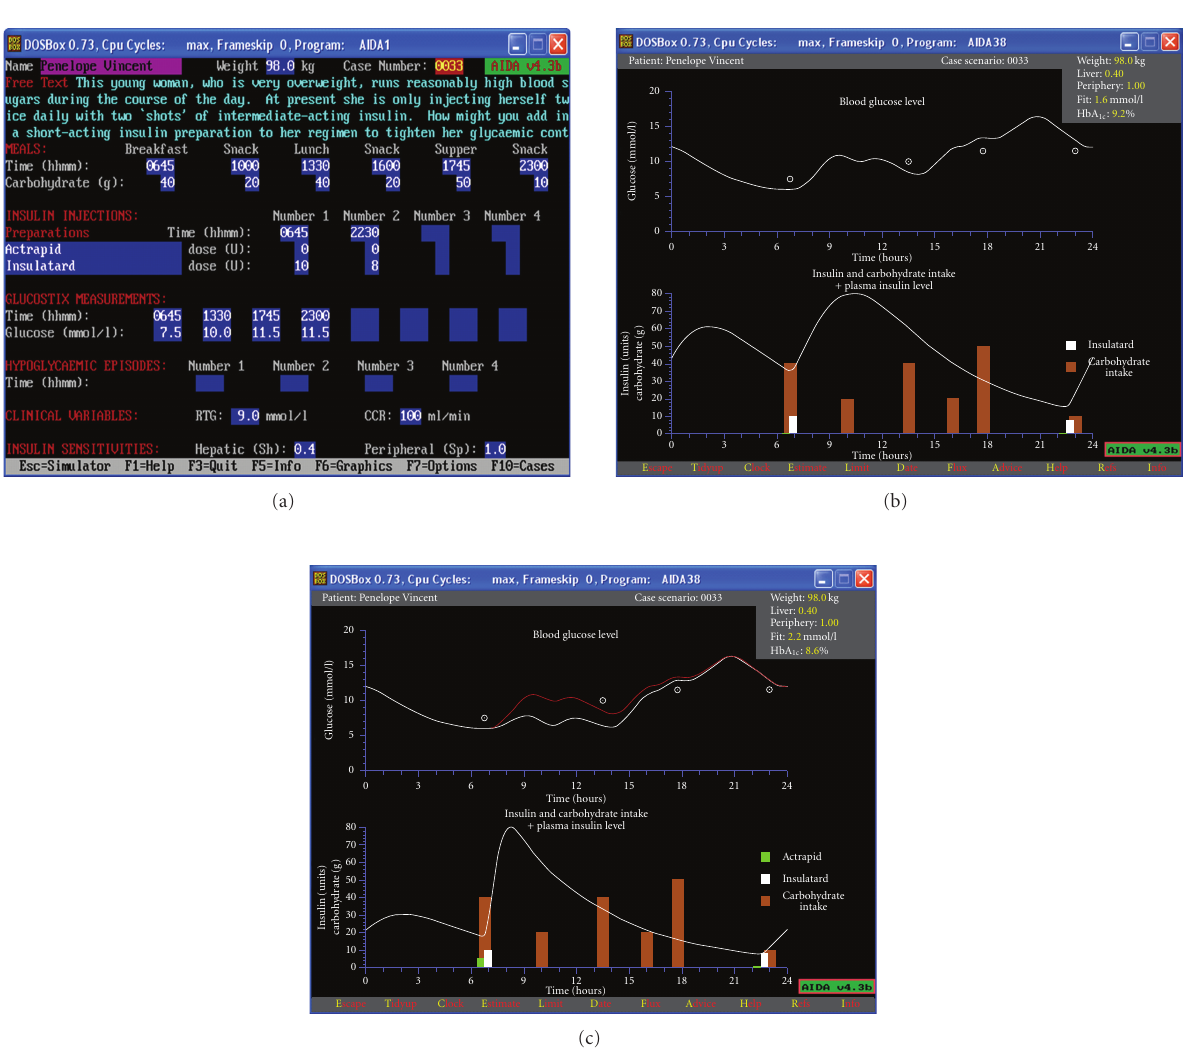
Figure 2: (a) Data entry screen for AIDA software showing the information stored by the program and used to generate its simulations. It recounts for “Penelope Vincent”—Case Scenario number 0033 in the AIDA database—that “ This young woman, who is very overweight, runs reasonably high blood sugars during the course of the day. At present she is only injecting herself twice daily with two “shots” of intermediate-acting insulin. How might you add in a short-acting insulin preparation to her regimen to tighten her glycaemic control? Alternatively, see if you can decrease her carbohydrate intake—thereby perhaps helping her to lose weight—and at the same time improving her blood glucose control ... . ” (b) Baseline simulation for “Penelope Vincent” Case Scenario number 0033 in the AIDA database using the data shown in Figure 2(a). On the lower graph insulin intake (Insulatard) twice per day is shown as white bars with the simulated plasma insulin profile superimposed. Also shown as brown bars are the carbohydrate intake. On the upper graph the simulated blood glucose profile is shown, with an estimated glycosylated haemoglobin level (HbA 1c ) of 9.2%. (c) shows the e ff ect on Penelope Vincent’s blood glucose (BG) profile of adding 5 units of a short-acting (Actrapid) insulin injection at 6 :45am. The baseline simulation from Figure 2(b) is shown as the red curve (for comparison). As can be seen, the addition of 5IU of short-acting insulin reduces the BG profile during the day—and leads to an improvement in the estimated medium-term index of the patient’s simulated glycaemic control with an HbA 1c of 8.6% (reduced from 9.2% for the simulation shown in Figure 2(b)). However, please note that, while this improves Penelope’s BG profile, this adjustment does not correct the high BG level in the